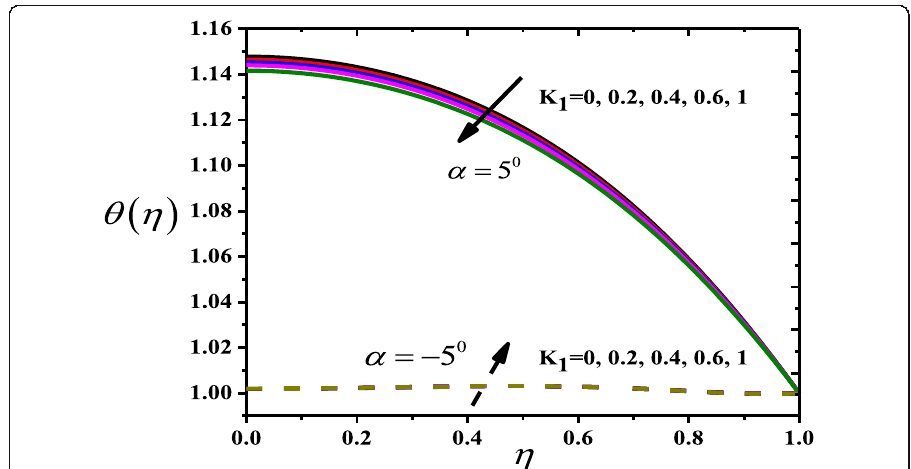
Fig. 8 Temperature vs. K 1 in stretching divergent and shrinking convergent channels